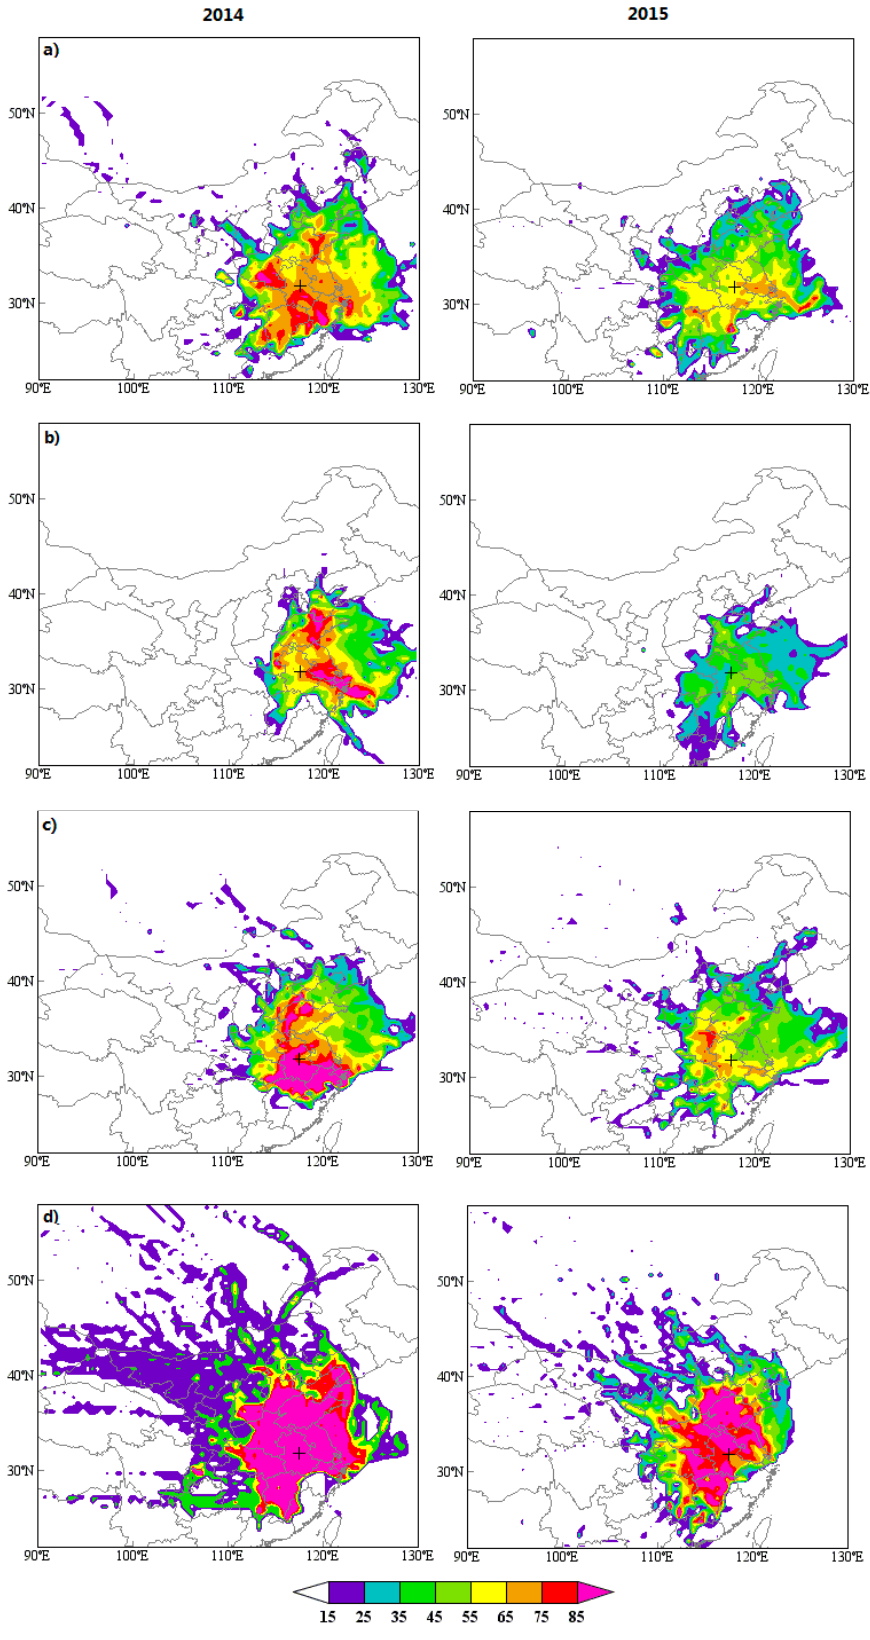
Figure 8. Seasonal concentration-weighted trajectory (CWT) maps for PM 2.5 at Hefei in 2014 and 2015: ( a ) spring, ( b ) summer, ( c ) autumn, ( d ) winter. The center of Hefei is marked by the cross and the CWT values are displayed in color.